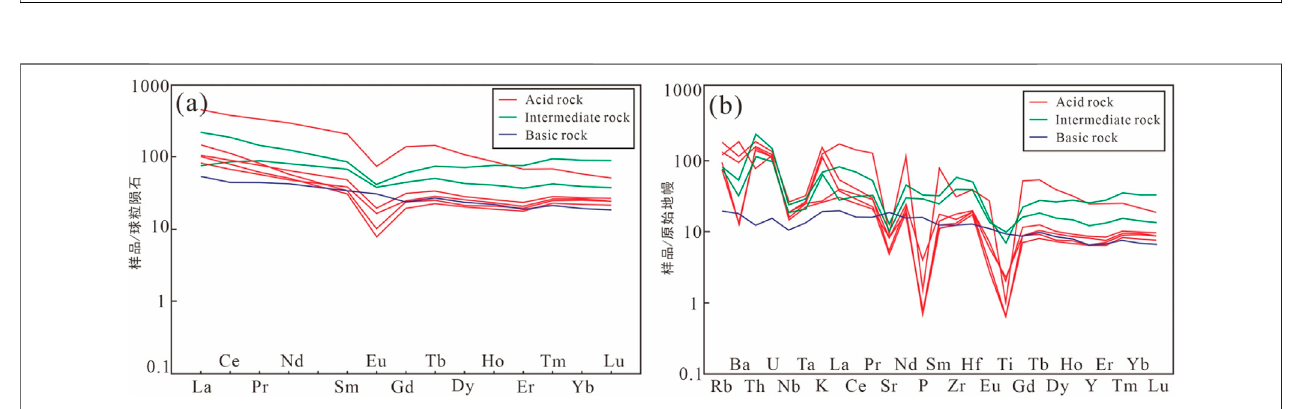
FIGURE 9 | Chondrite-normalized REE patterns (A) and primitive mantle-normalized trace element patterns (B) for the Carboniferous volcanic rocks in the Shixi area.